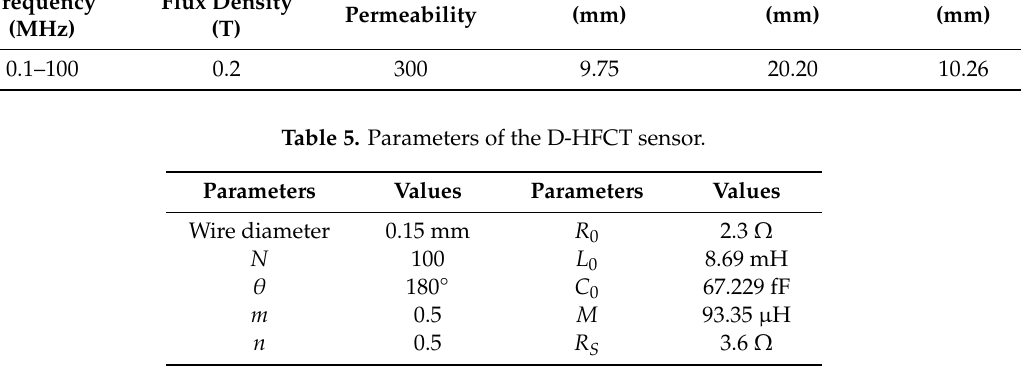
( a ) ( b ) Figure 16. Frequency response of the D - HFCT sensor. ( a ) fFC 67 0 = ; ( b ) 0 C increases. 4.2. Series Arc Fault Simulation Experiment System The series arc fault experiment simulation system was designed as shown in Figure 17 and Figure 18. The 220 V, 50 Hz AC power was connected between the live line and the neutral line. Three sensors were selected in the experiment: Sensor 1 was a 1 ohm power resistor rated at 5000 W for collecting the actual current signal. The voltage across the resistor was equal to the value of the current flowing. The purpose of setting Sensor 1 was to collect current signals of all frequencies and to compare the signal acquisition effects with that of CT and D-HFCT. For Sensor 2, the model was HCT215-5 A/2.5 mA, which is a common straight-through current transformer. It operated at 50 Hz and was used to acquire low-frequency current signals. In the experiment, the sampling resistance of Sensor 2 was 100 ohms. The acquired signal waveform was compared with that of Sensor 3 to